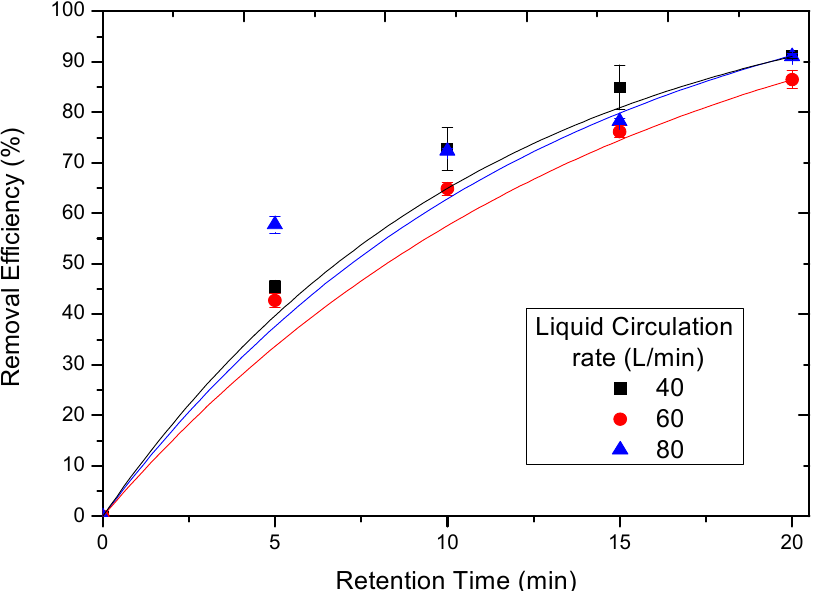
Figure 4. Effect of the liquid circulation rate on the efficiency of HFC-134a removal. (Initial HFC-134a conc.: 772 mg/L, air flow rate: 10 L/min).